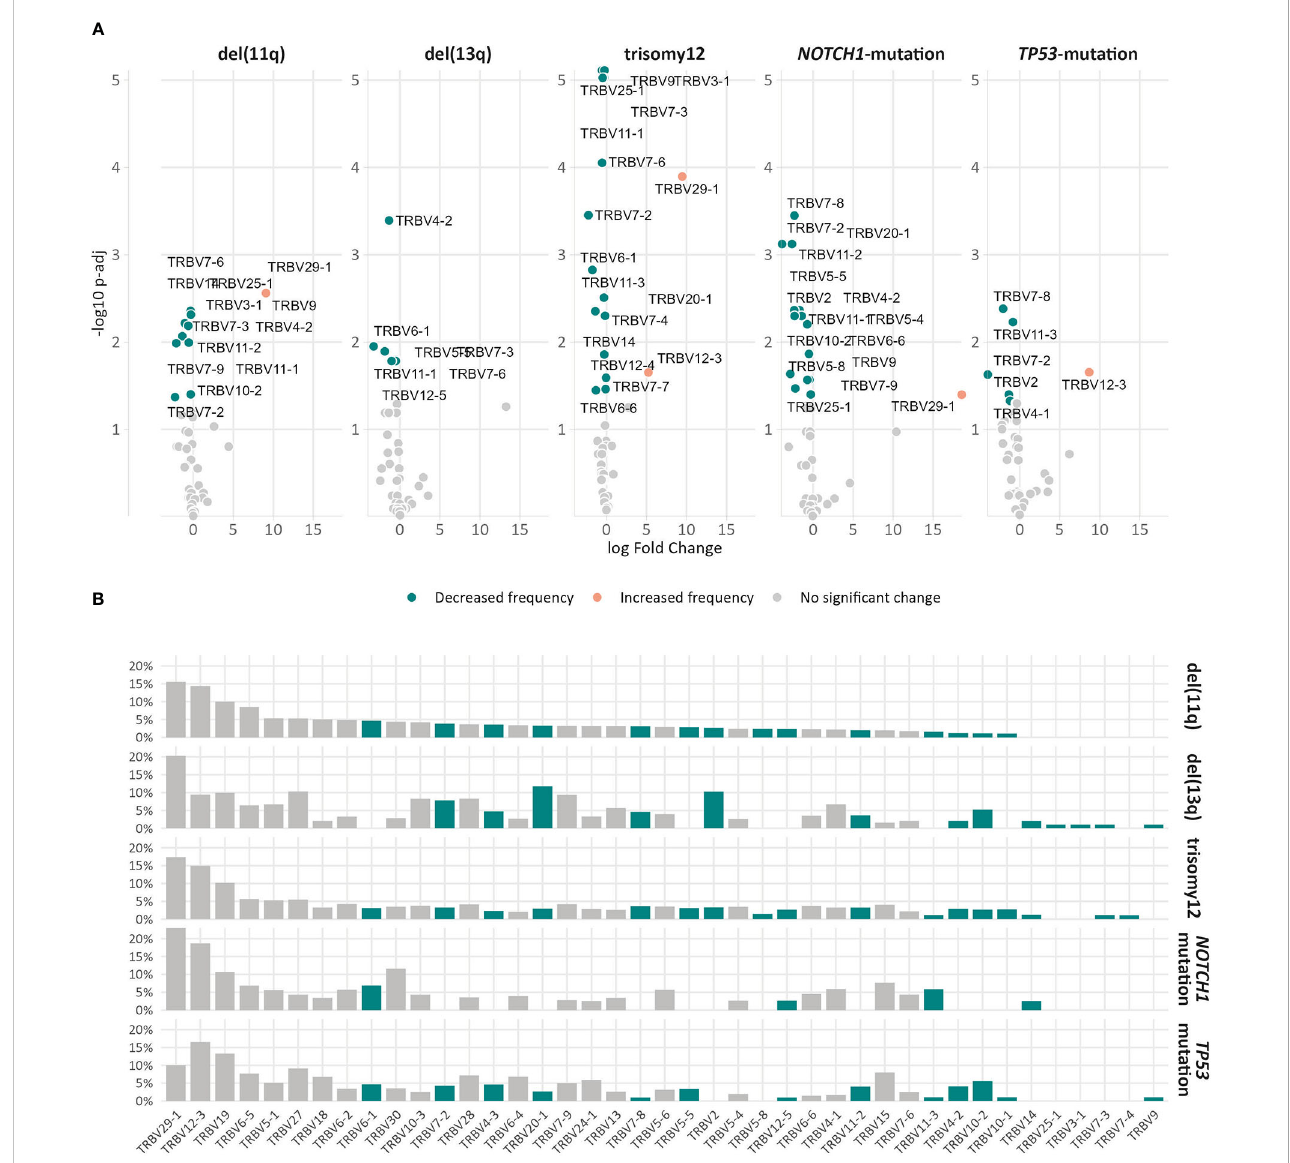
FIGURE 5 Differential usage of TRBV genes in the repertoires of the expanded clonotypes of the various groups in the study. (A) Volcano plots depict the signi fi cant variation in the TRBV gene usage in the repertoire of expanded clonotypes ’ compared to the remaining polyclonal background within a given group. TRBV genes with decreased frequency in the repertoire of expanded clonotypes are depicted as petrol bubbles, whereas TRBV genes with increased frequency are depicted as orange bubbles. (B) TRBV gene frequencies in the repertoire of expanded clonotypes in each group. The colored bars represent TRBV genes with statistically signi fi cant differences between the different